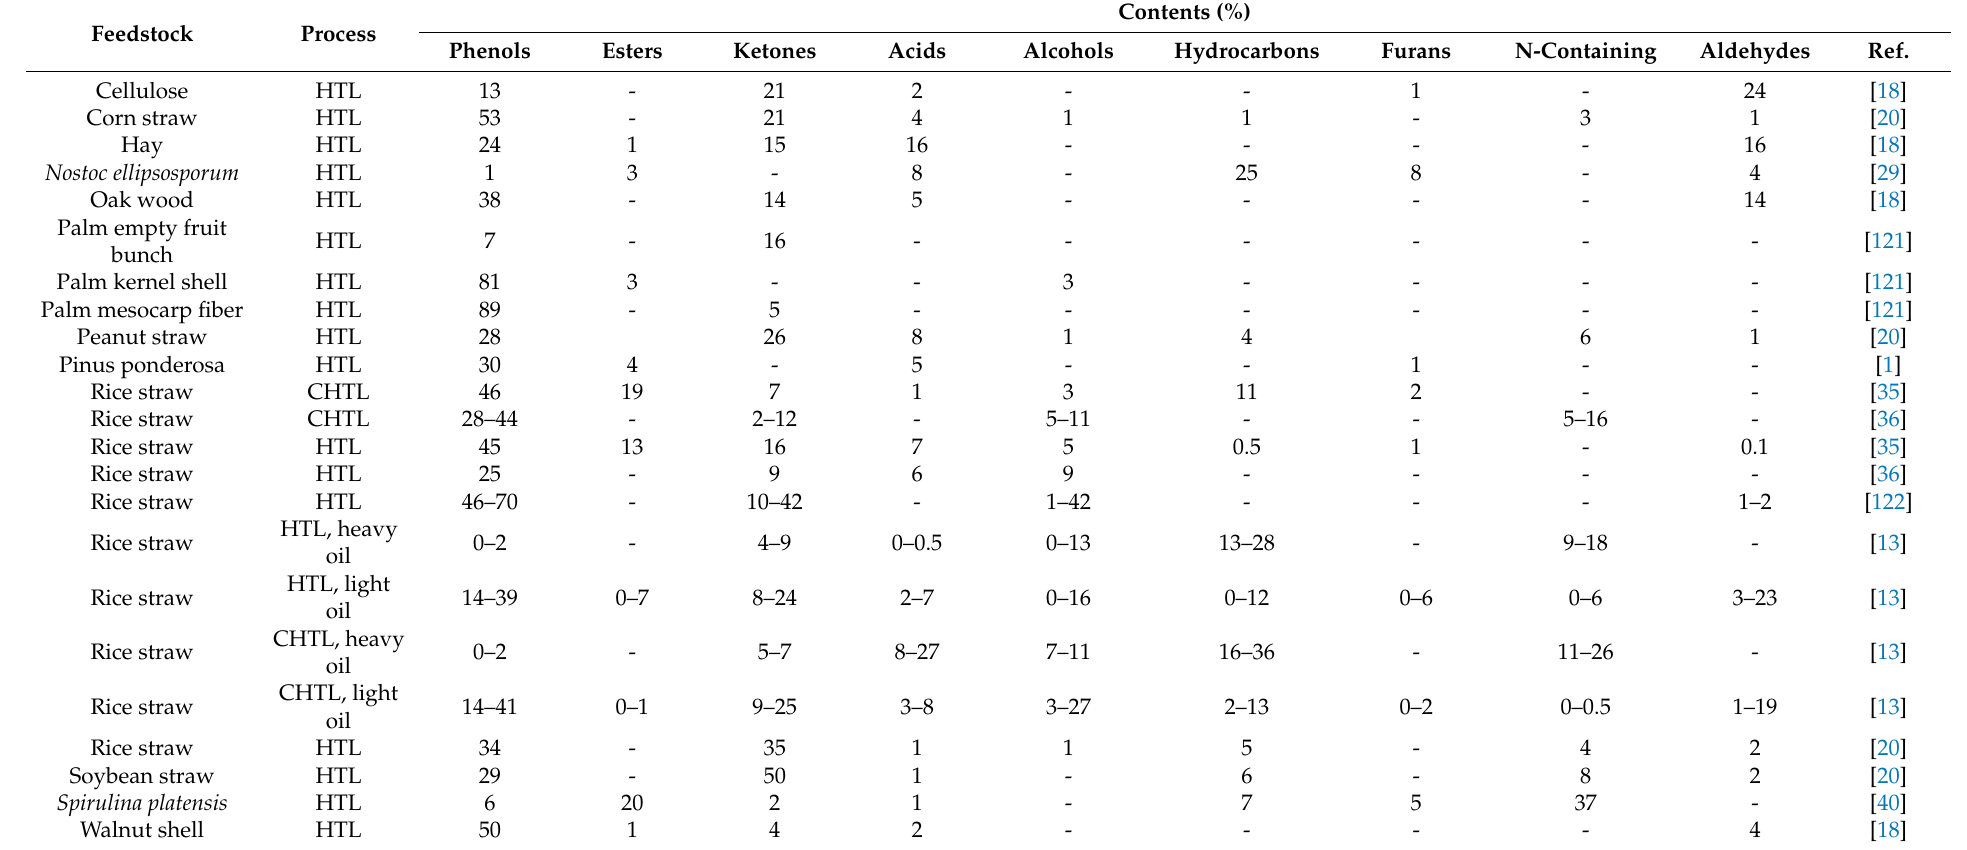
Table 5. Summary of approximate bio-oil compositions from works in Table 1 or others of